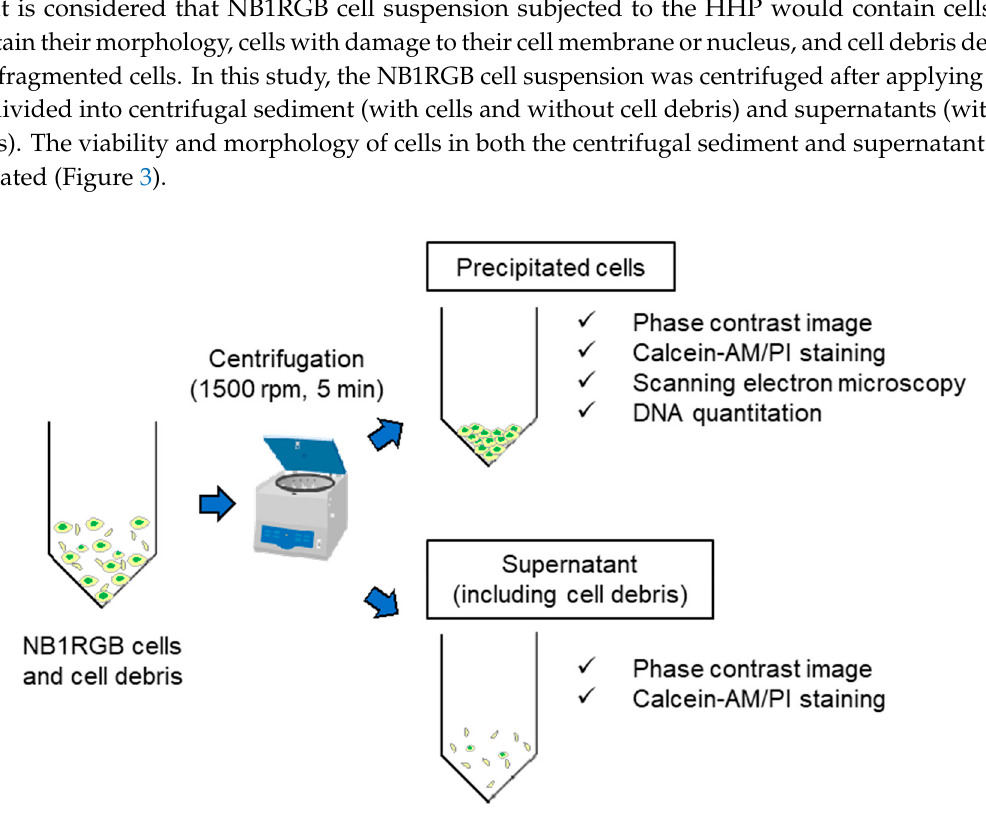
Figure 3. Procedure after applying HHP. After HHP was applied, NB1RGB cell suspension was transferred from the bag to the tube, then centrifuged to separate the cells and cell debris. The precipitated cells and the cells or cell debris contained in the supernatant were evaluated, respectively.